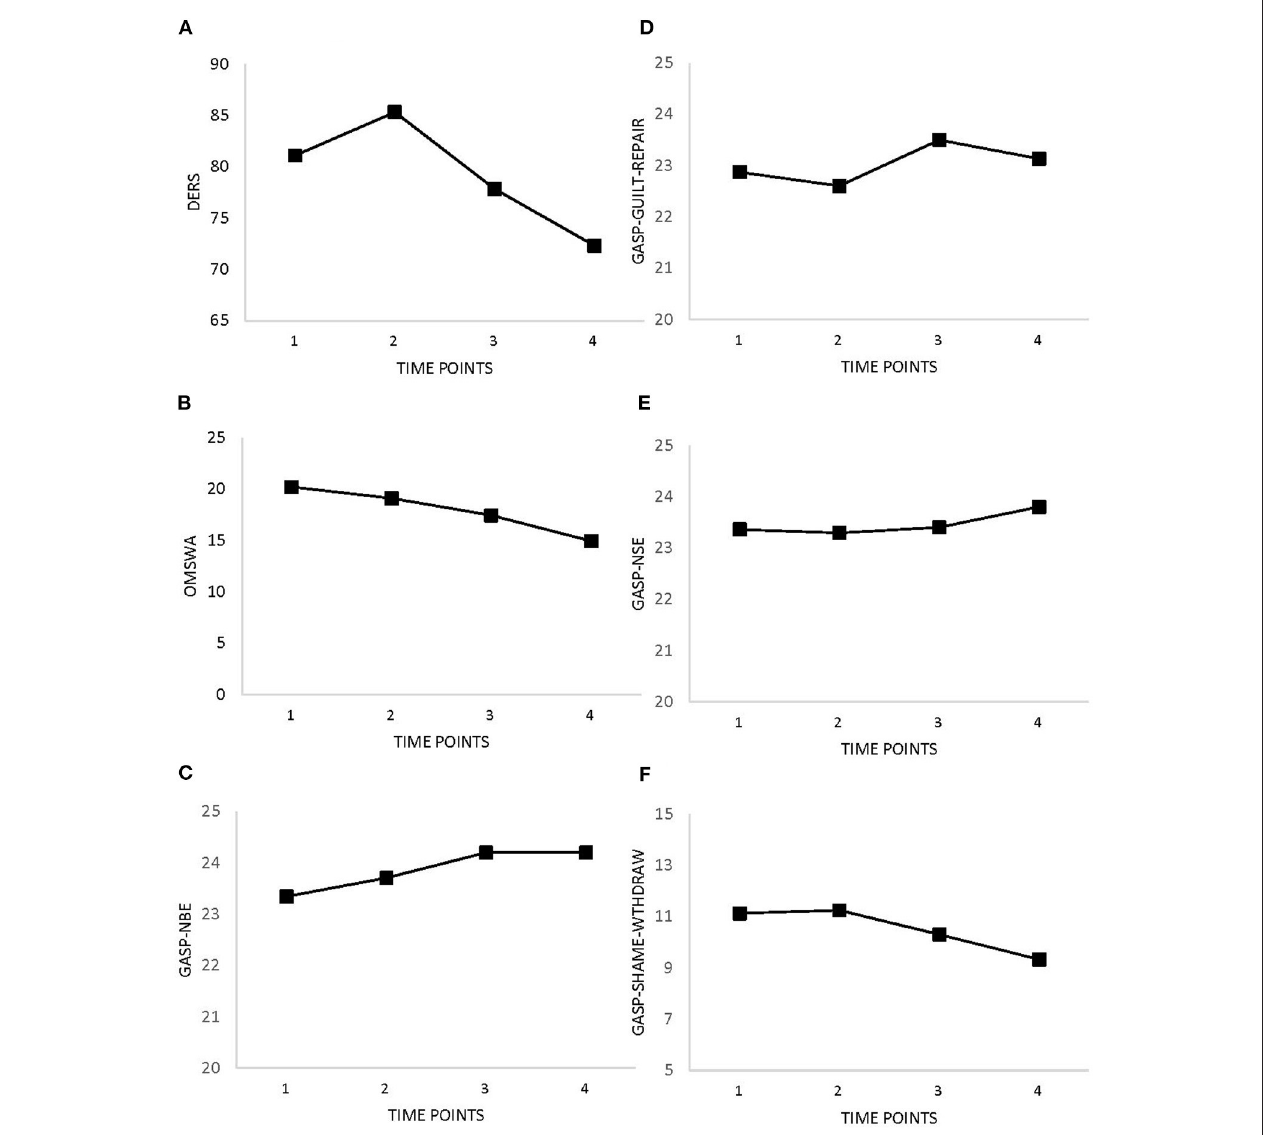
FIGURE 2 | Changes in self-reported emotion regulation, stigma, guilt and shame as measured at baseline (Time 1), 8 weeks (Time 2), 3 months (Time 3), and 6 months (Time 4). (A) Emotion Regulation (DERS). (B) Stigma (OMSWA). (C) Guilt-Negative Behavior Evaluation (GASP). (D) Guilt-Repair (GASP). (E) Shame-Negative Self-Evaluation (GASP). (F) Shame-Withdraw